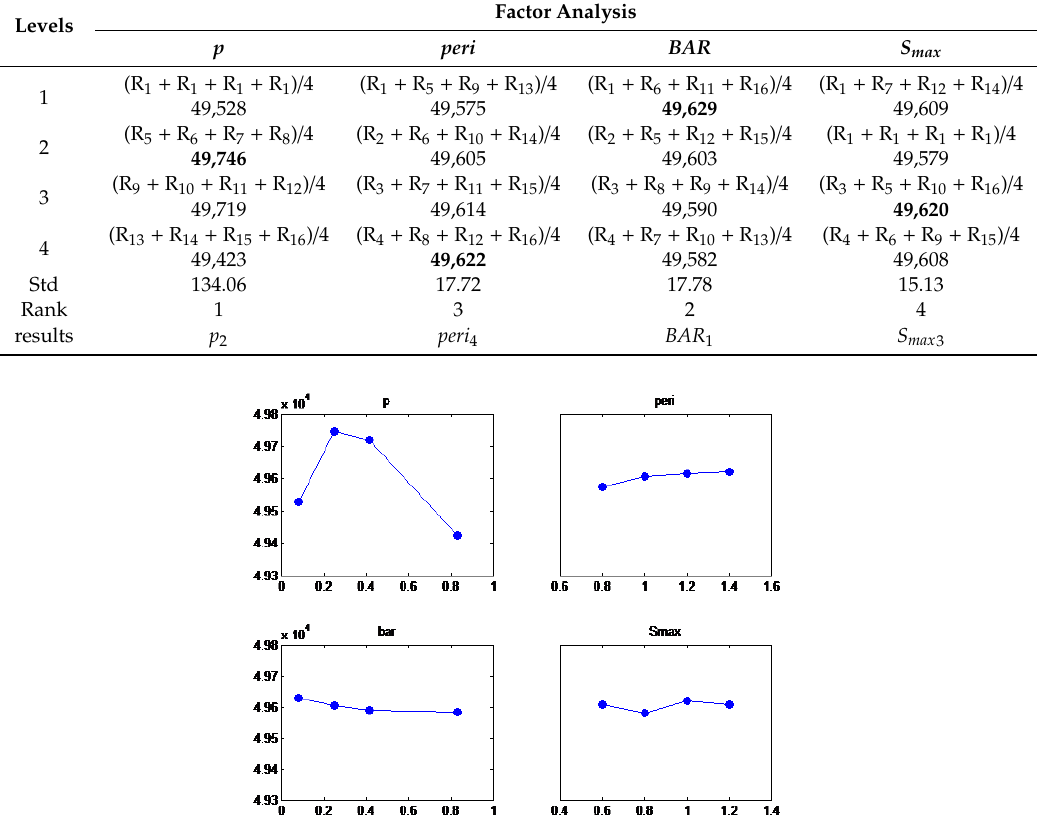
Figure 3. The changing trends of all the factor levels.